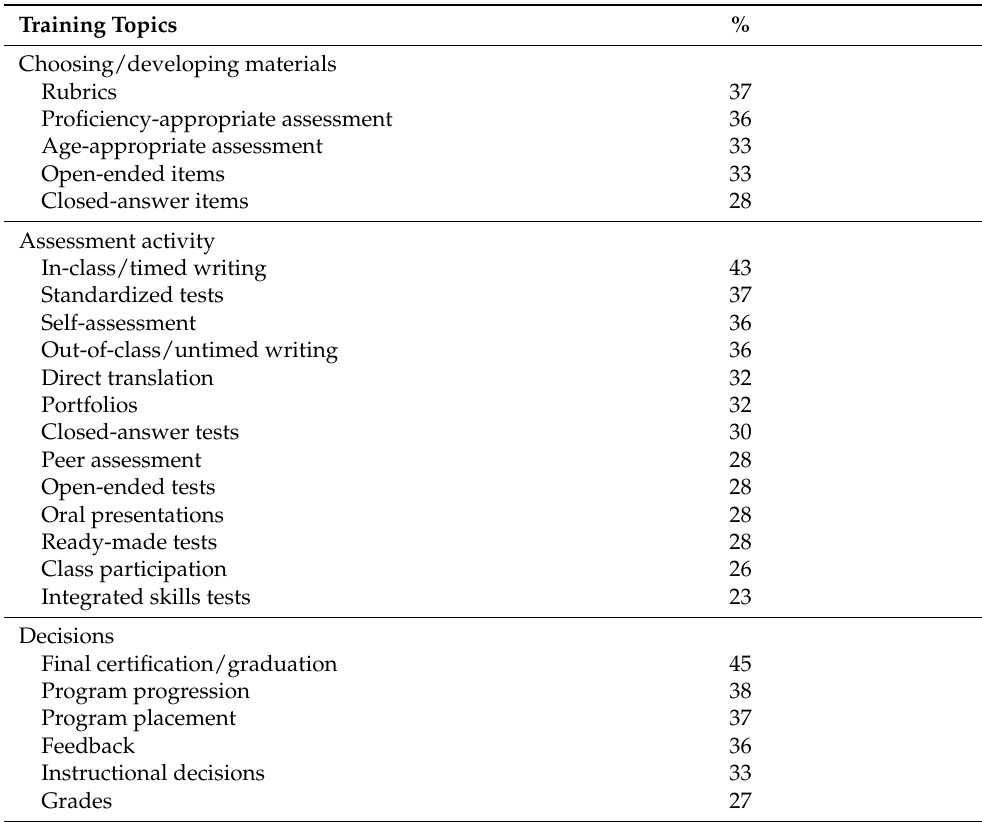
Table 9. Desired training topics by